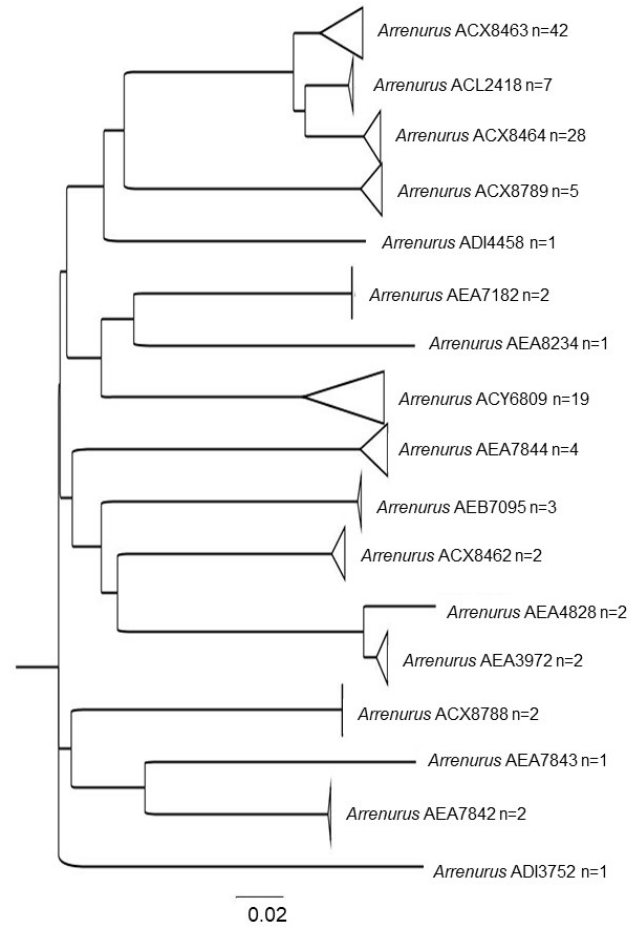
Figure 6. NJ tree for Arrenuridae family.